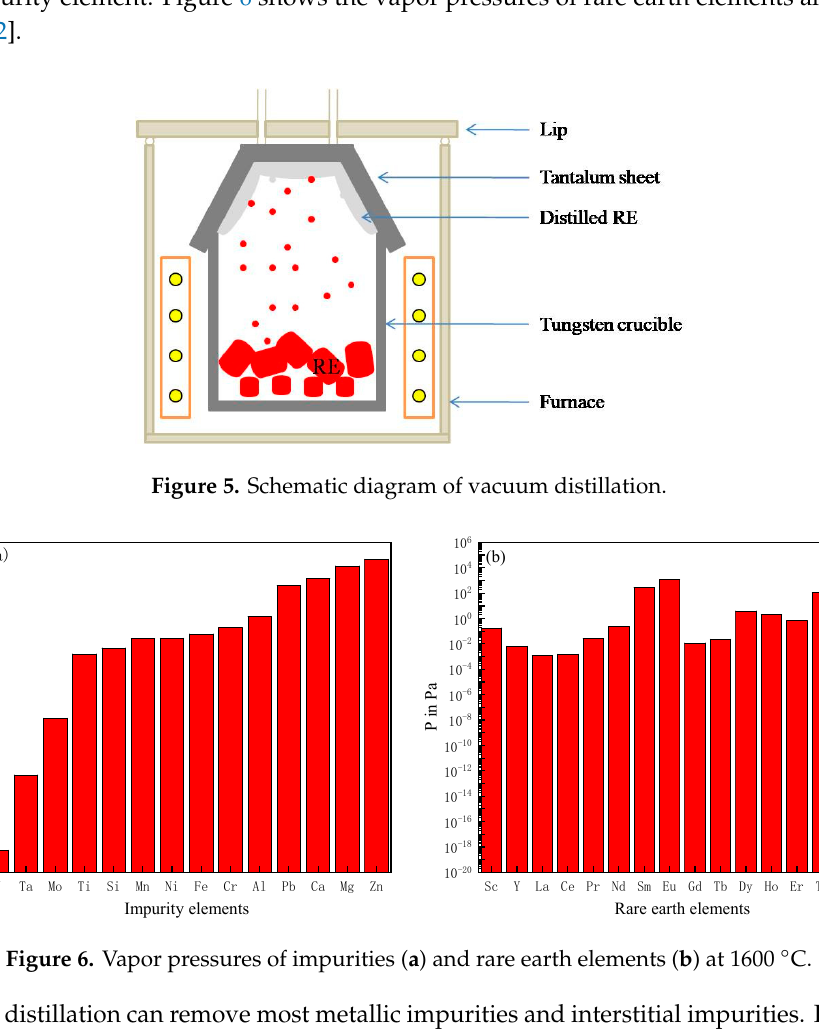
Figure 6. Vapor pressures of impurities ( a ) and rare earth elements ( b ) at 1600 °C.